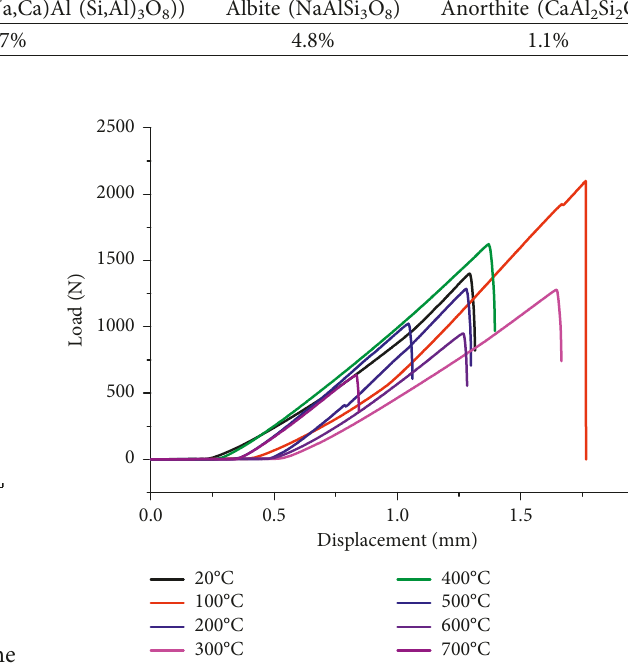
Figure 4: Typical load-displacement curve of sandstone at various